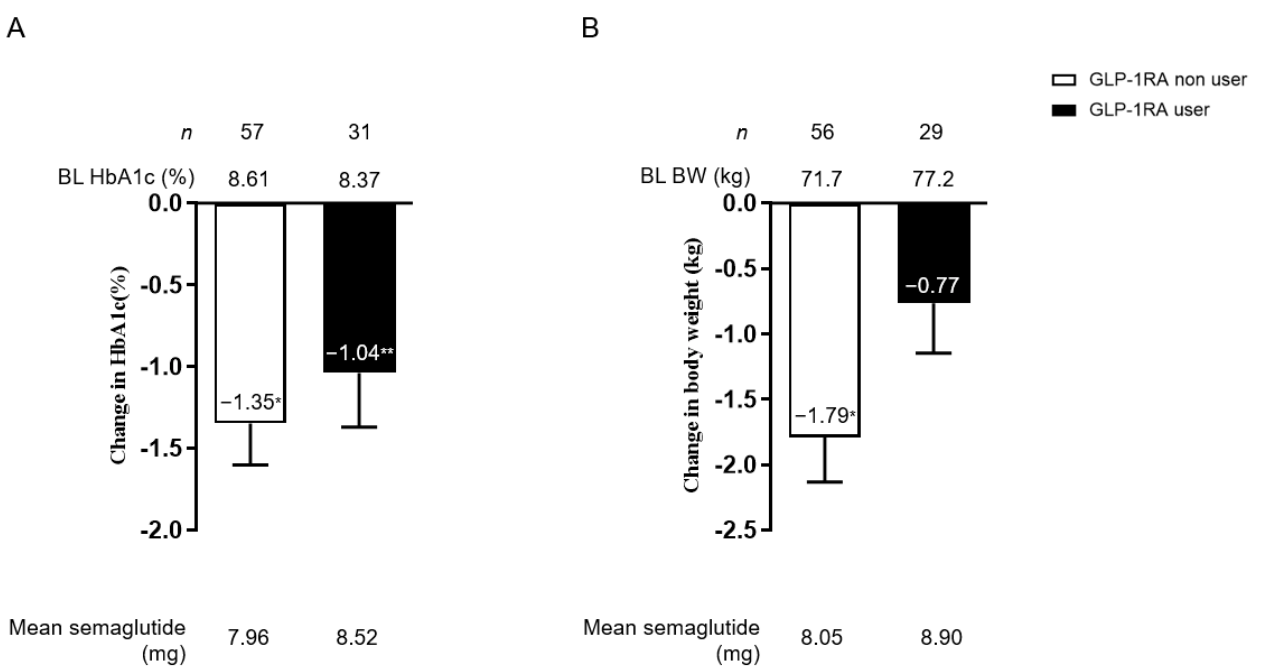
Figure 4. Change in HbA1c ( A ) and BW ( B ) from baseline among prior GLP-1RA non-users and users. White bars indicate GLP-1RA non-users and black bars indicate GLP-1RA users. The mean oral semaglutide dosage is shown at the bottom of the figure. Data in the figure are presented as mean with SEM. * p < 0.001; ** p < 0.01 in the Wilcoxon signed-rank sum test (vs. BL HbA1c). BL, baseline; HbA1c, glycated hemoglobin; BMI, body mass index; GLP-1RA, glucagon-like peptide-1 receptor agonist; SEM, standard error of the mean.